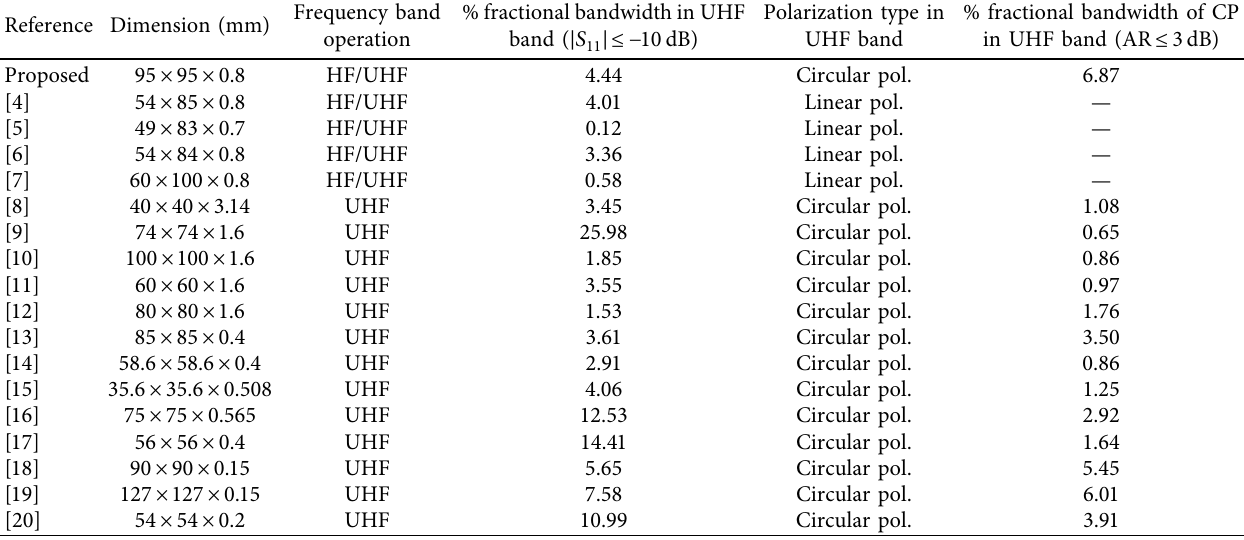
Table 3: Performance comparison of the proposed integrated HF-RFID and UHF-RFID tag antenna with current state of the art in RFID tag antennas. Frequency band Reference Dimension (mm) operation